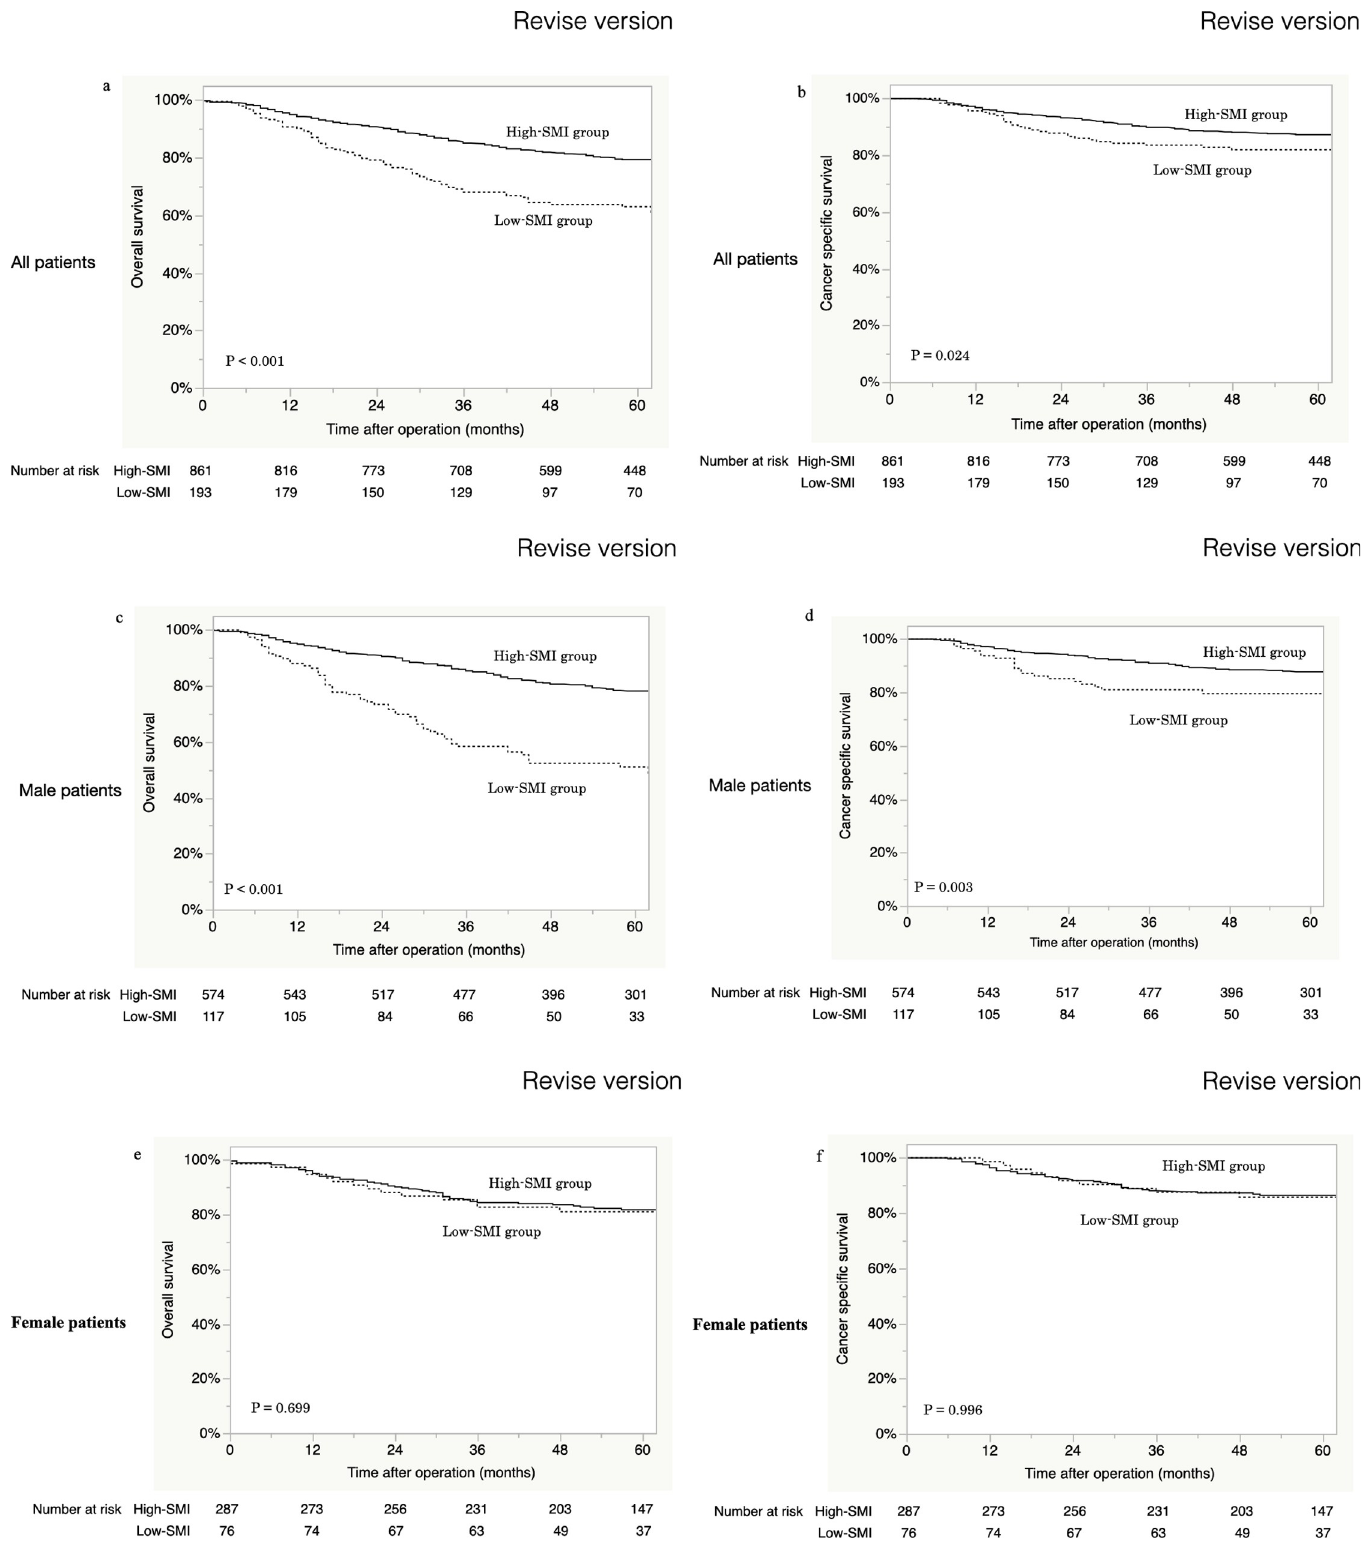
Fig 2. Overall (a) and cancer-specific (b) survival according to SMI status in all patients. Overall (c) and cancer-specific (d) survival according to SMI status in male patients. Overall survival (e) and cancer-specific survival (f) according to SMI status in female patients.